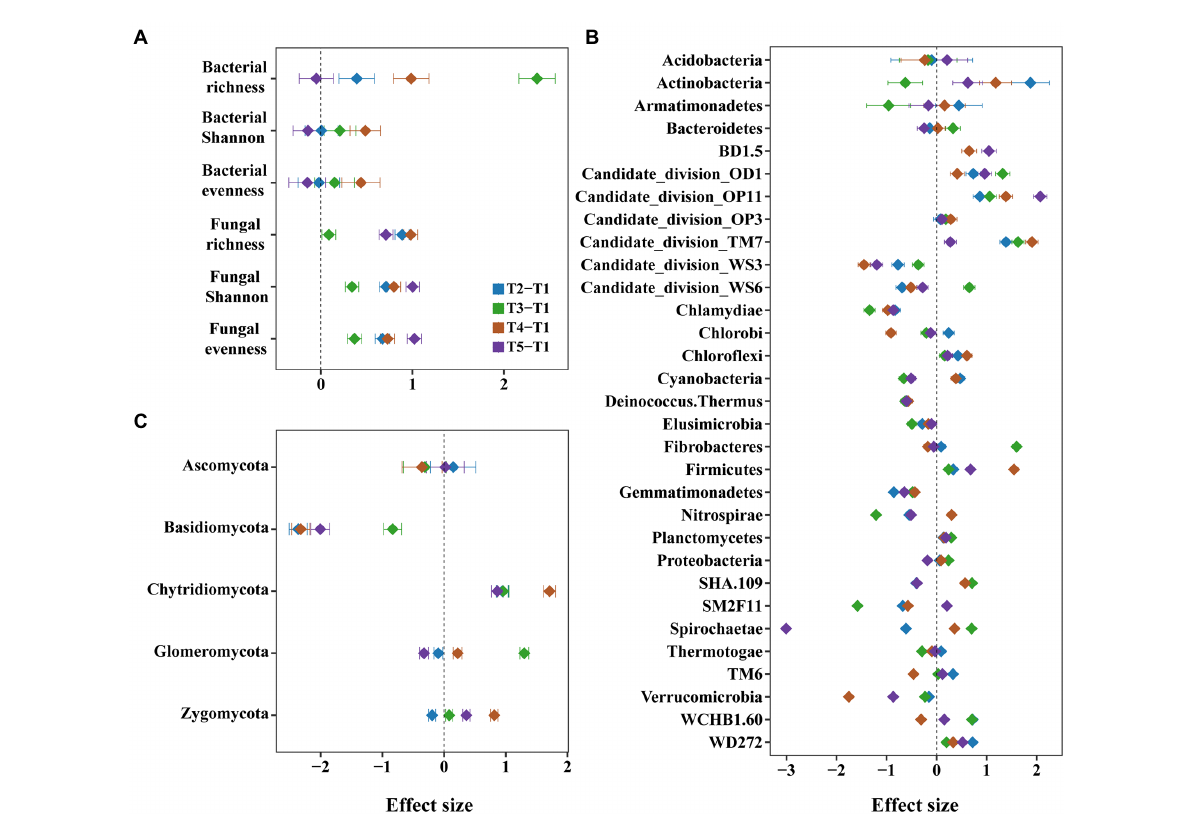
FIGURE 3 The effects of monocropping and intercropping on soil microbial diversity and communities. We considered the microbial diversity such as species richness, Shannon and evenness of bacteria and fungi (A) , and the microbial community such as relative abundance of bacterial (B) and fungal phyla (C)